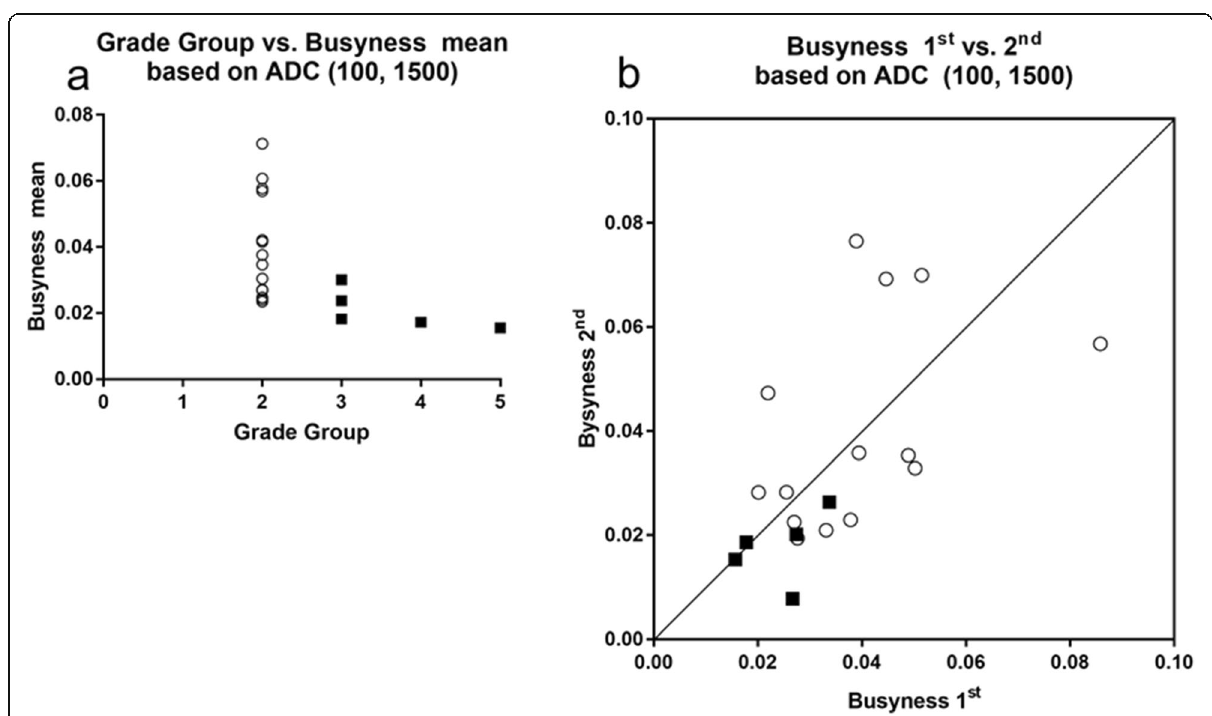
Fig. 5 Transition zone cancer. a Correlation between grade group and mean of the first and second busyness of neighborhood gray-level difference matrix based on apparent diffusion coefficient (ADC) (100, 1,500). b XY plot of the first and second busyness of neighborhood gray- level difference matrix based on ADC (100, 1,500). Open circle, closed square, and line indicate grade group (GG) of 1 and 2, GG of 3, 4, and 5, and Y = X line,